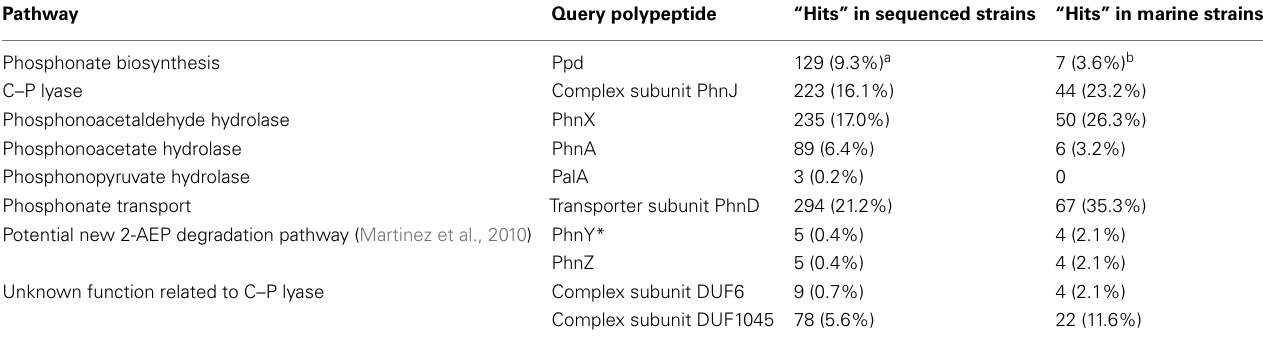
Table 2 | Homologs retrieved from the NCBI bacterial genomes database that indicate possession of pathways of phosphonate metabolism.